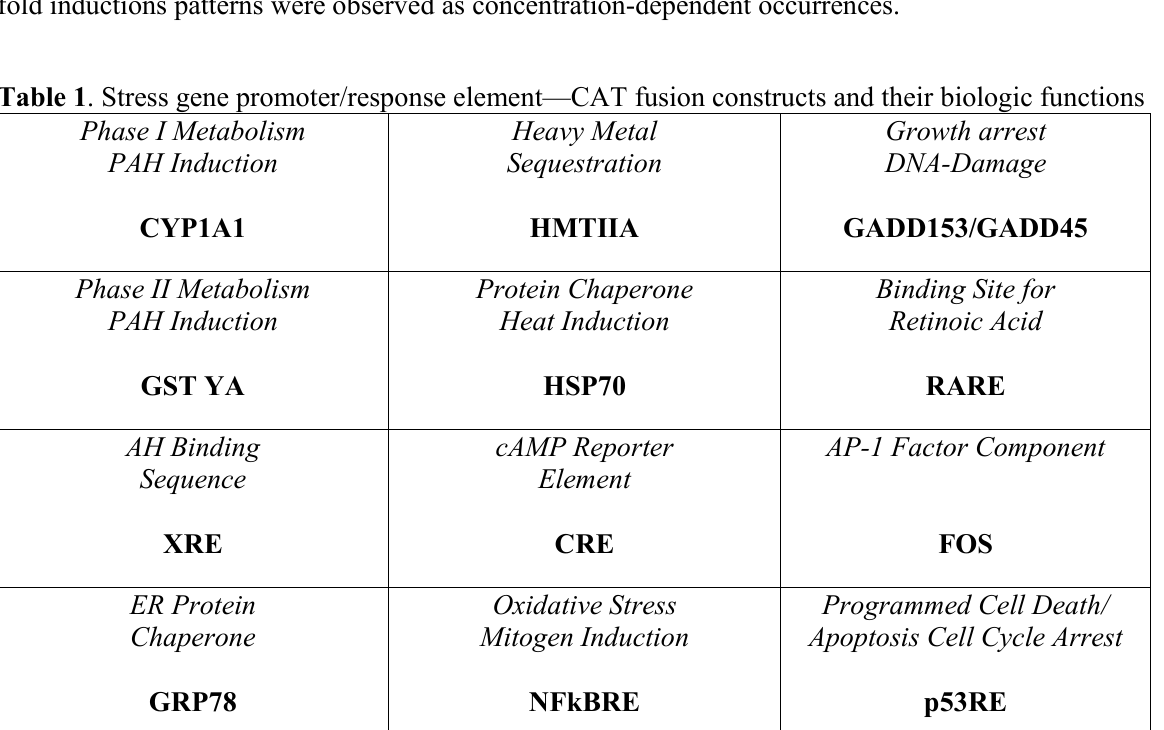
Figure 1. Toxicity of pentachlorophenol to human liver carcinoma cells (HepG treated with serial dilutions (0-100 µg/mL) of PCP. Cell viability was measured by MTT assay as indicated in the methodology section. Absorbance readings taken from survival cells were converted